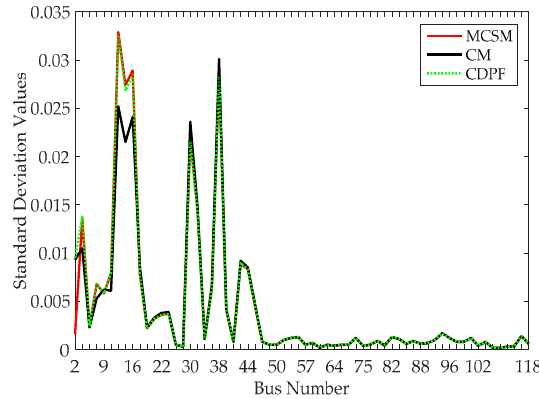
Figure 14. The Standard deviations of the bus voltage magnitude at PQ buses in an IEEE 118-bus power system. Table 5. CPU time and calculation number N PL of DPF.